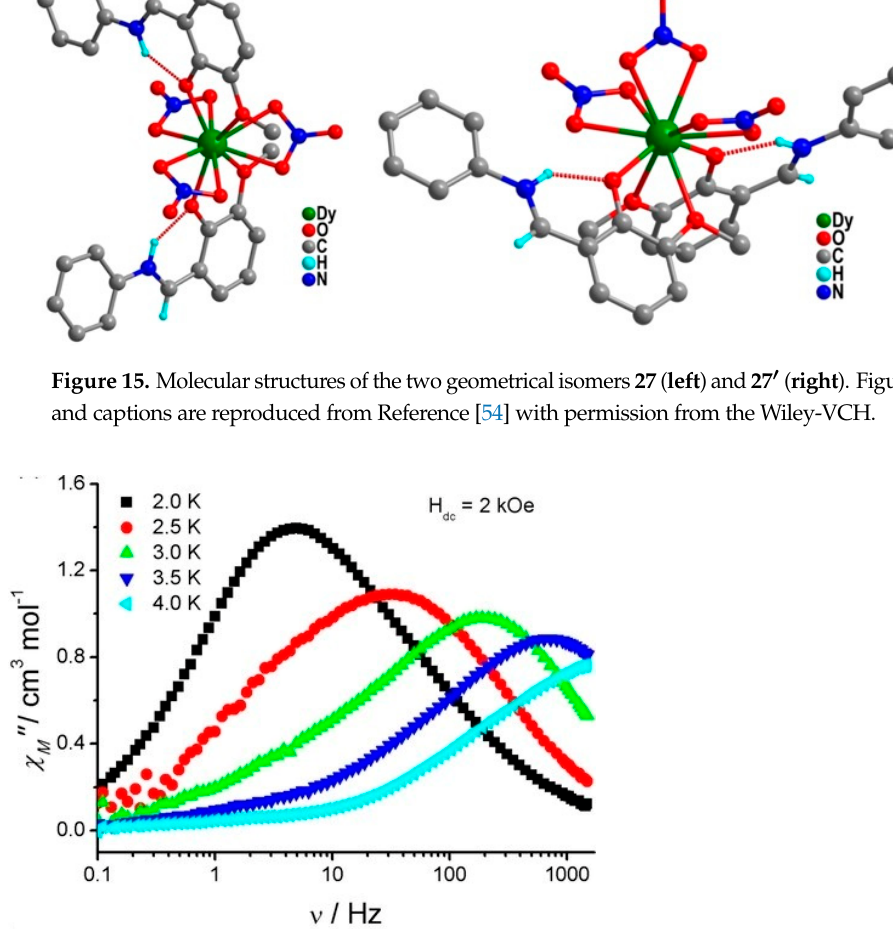
Figure 16. Frequency-dependent out-of-phase susceptibility data measured for polycrystalline sample of 27 . Figures and captions are reproduced from Reference [54] with permission from the Wiley-VCH.